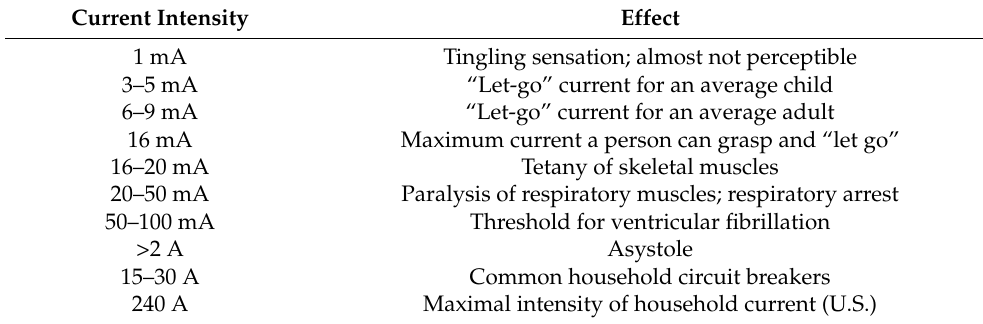
Table 1. Pathophysiologic effects of different intensities of electrical current